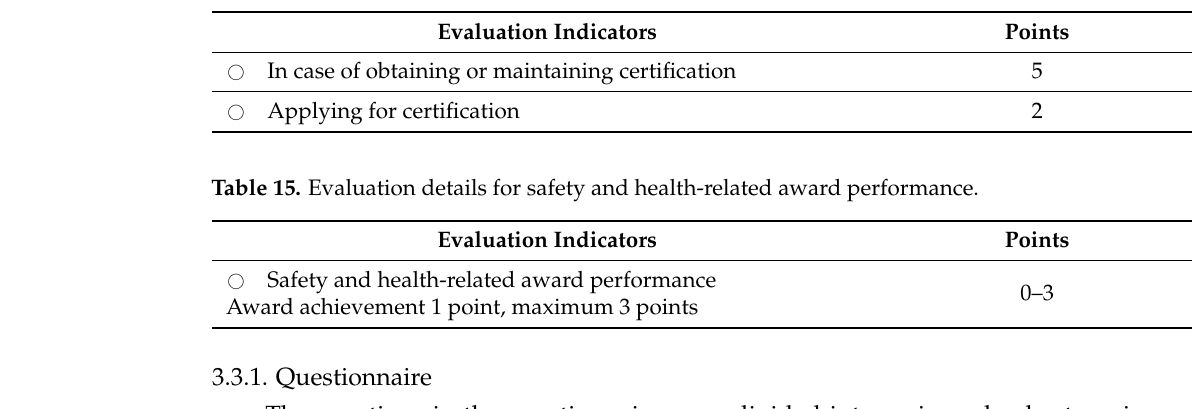
Table 14. Evaluation details for KOSHA-MS certification.